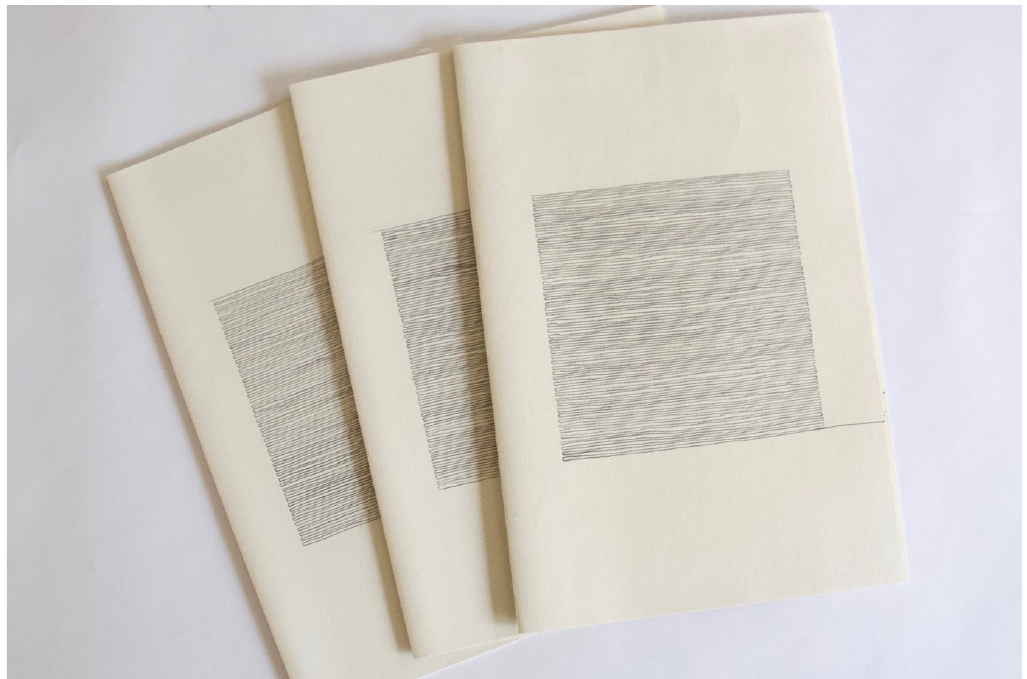
Figure 10. A line that, in theory, could connect us , 2019. Studio experiment detail. Pencil on paper. Collection of the artist.